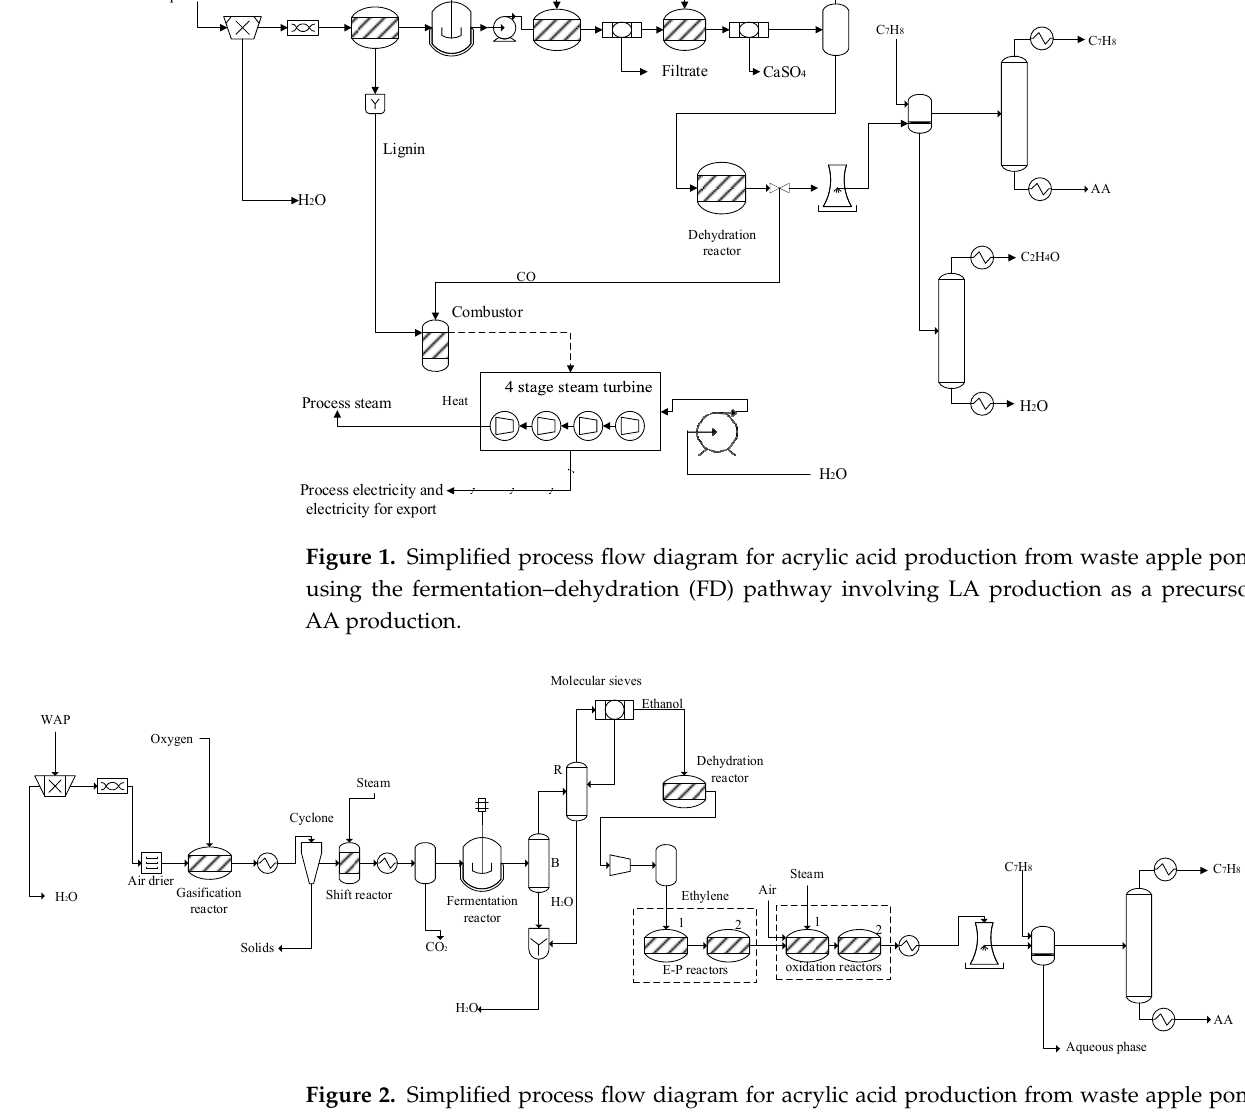
Figure 2. Simplified process flow diagram for acrylic acid production from waste apple pomace using the thermochemical–fermentation–oxidation pathway involving propylene production as a precursor.